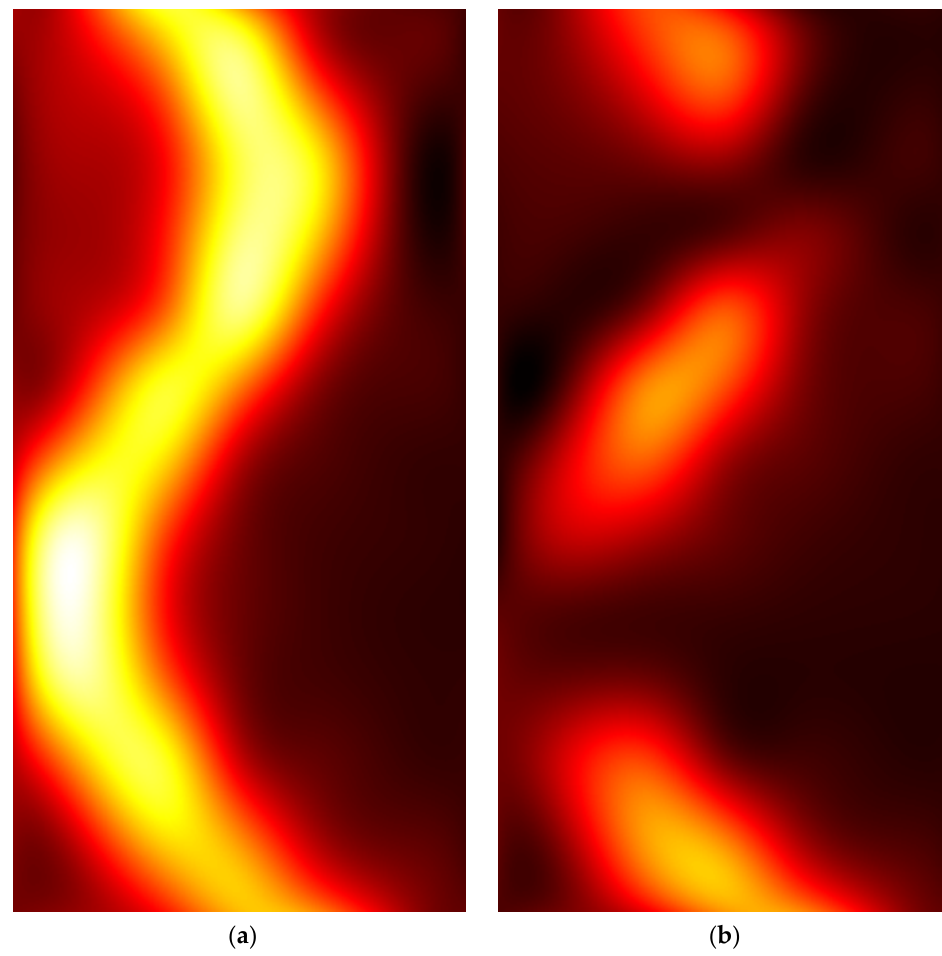
Figure 6. False-color images of the interpolated amplitude matrices were obtained from the copper wire with the coil aligned ( a ) along the x -axis ( V x The estimate of the copper wire position, obtained by maxima search along the V matrix rows and the following thresholding, is depicted in Figure 8b, while Figure 8a shows a picture of the copper wire for visual